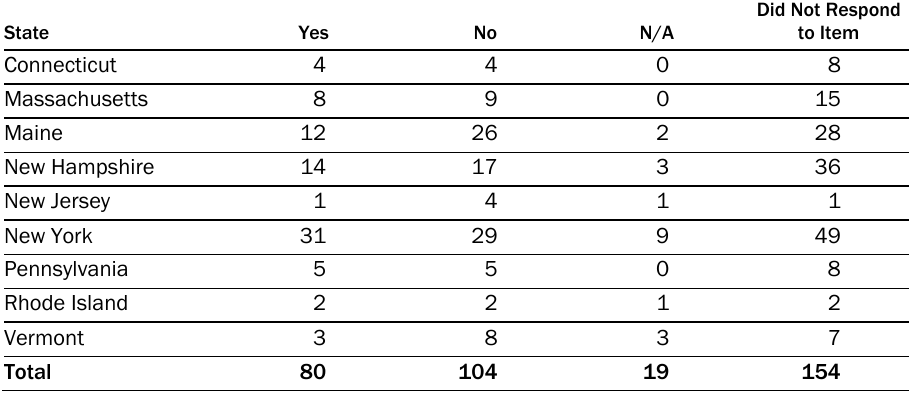
Table 8. State-by-State Responses to “Would You Like Help Creating Written